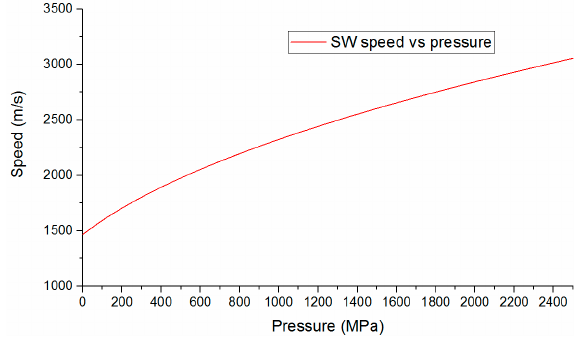
Figure 11. Dependence SW speed behind shock front on pressure.